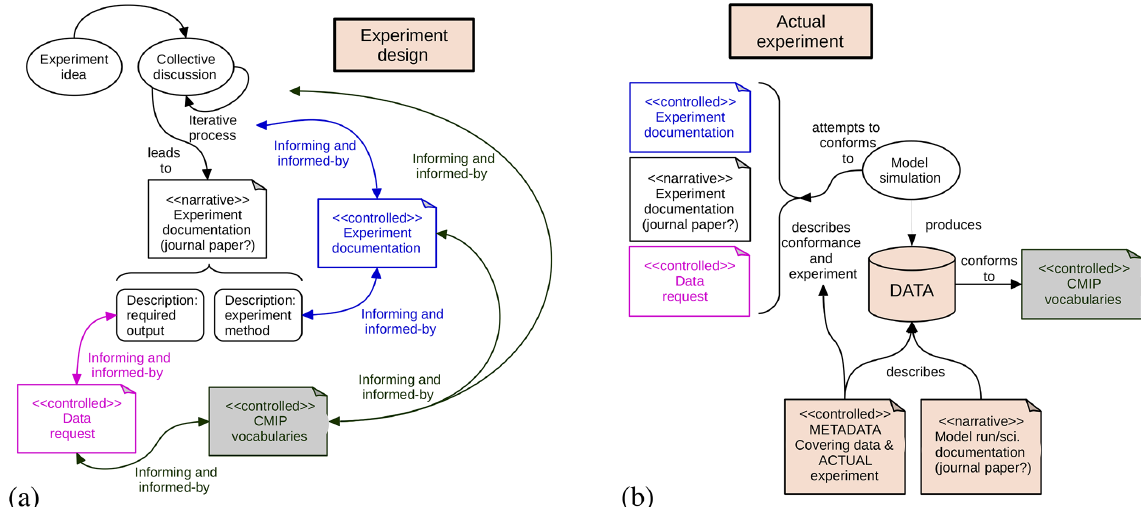
Figure 1. (a) The process of defining an “experiment” involves multiple steps, interactions, and component descriptions. In the simplest case, ideas are iterated leading to some sort of final description (white boxes), but at scale, there is a need to control the structure used to document the experiments (blue) and their intended output (data request, magenta), and such structure needs to utilize controlled vocabularies (shaded). (b) The realization of an experiment is carried out by a model simulation which produces data, but in practice simulations often deviate in detail from the experiment protocol, and such deviations themselves need to be recognizable; how well a simulation conforms to the protocol is a key element of the documentation. In both (a) and (b) the (cid:28) narrative (cid:29) and (cid:28) controlled (cid:29) notation indicates the key characteristics of the two types of documentation: the former in scientific prose for human readers, the latter more structured for consumption both by humans and automated